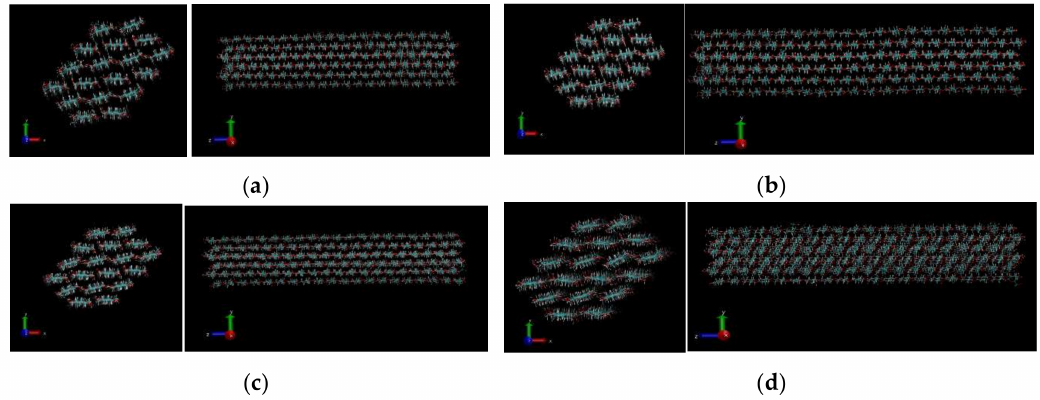
Figure 3. Case A: Structures of CNF after pull simulation at 200 ps for: ( a ) 1000 kJ / mol /